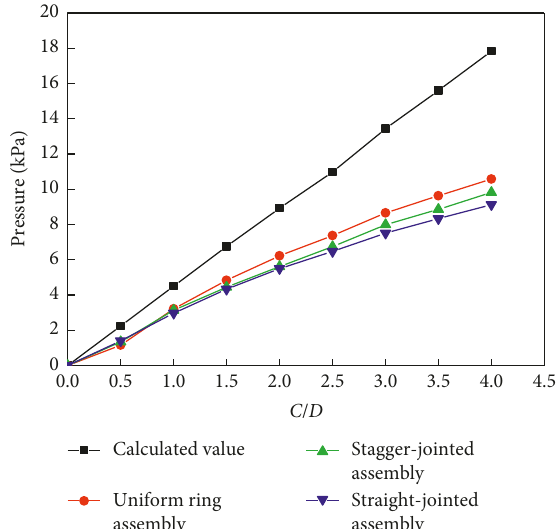
Figure 11: Variations in the average earth pressures acting on different ring crowns with increasing cover